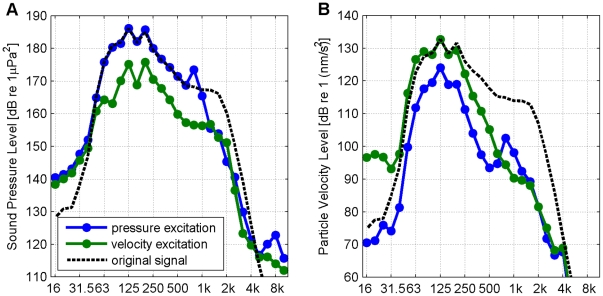
Comparison of the original and measured frequency spectra.Mean square sound pressure level spectrum (A) and particle velocity level spectrum (B) in 1/3-octave bands (averaged over 0.2 s intervals) for a pressure excitation, a velocity excitation and the original signal scaled to match the peak of the measured signal.